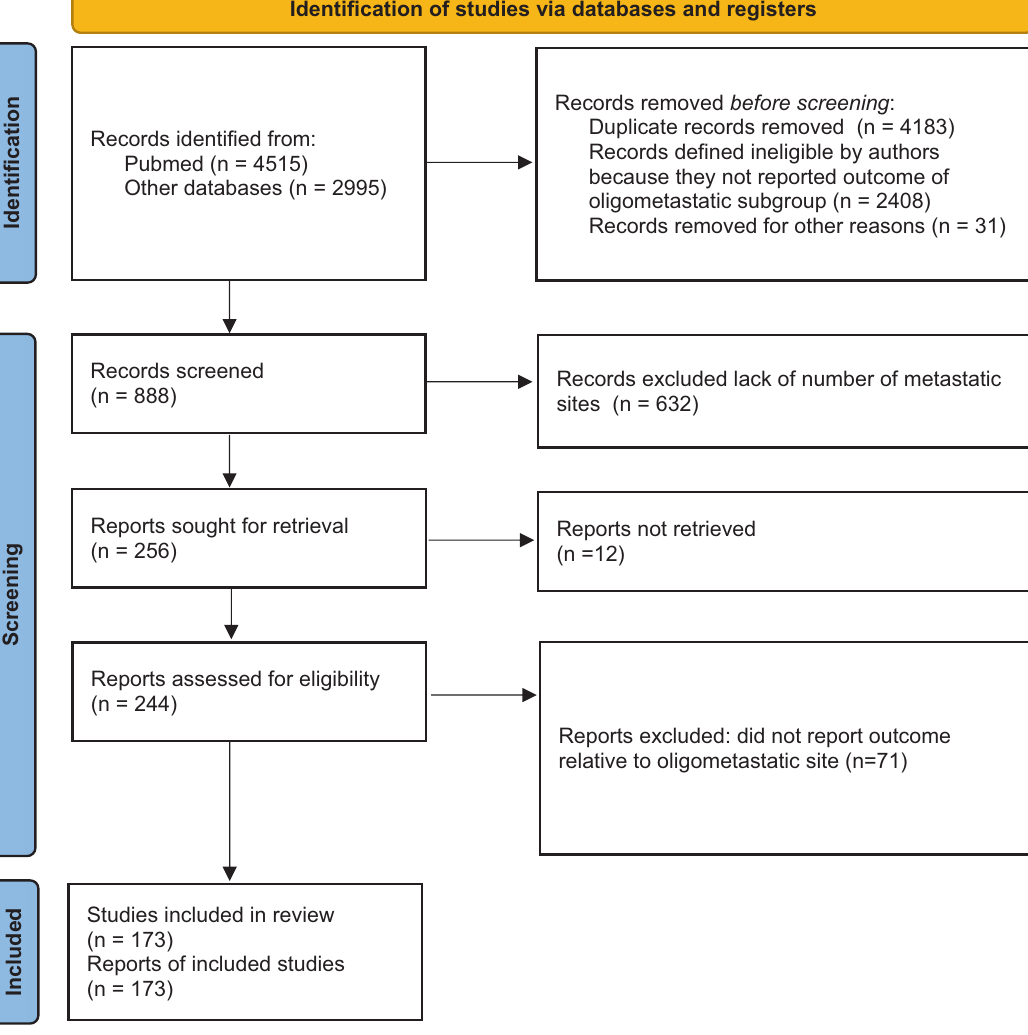
Figure 1. Preferred Reporting Items for Systematic Reviews and Meta-analyses (PRISMA) 2020 flow diagram showing the process of study